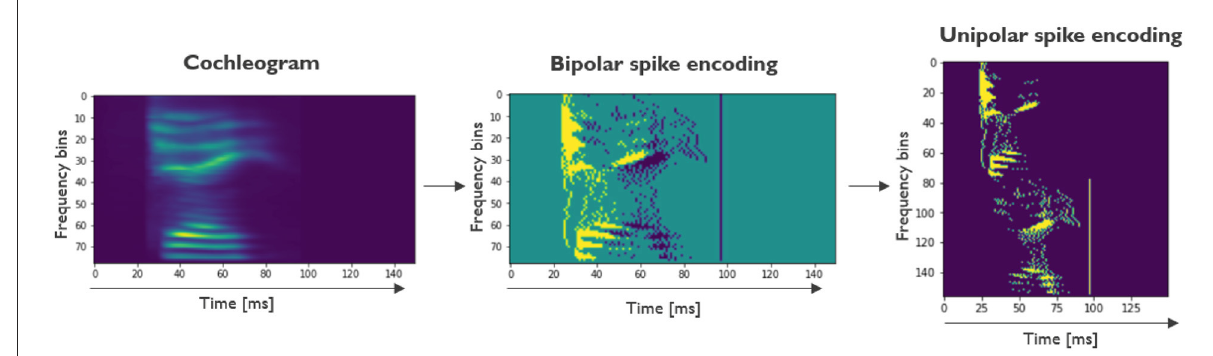
FIGURE2 Preprocessing pipeline shown on a training sample of the TI-Alpha data set. First, the sound files are transformed into a cocheogram, where the relative intensities are shown for various frequency bins. Next, the output of the step-forward encoding is shown, a bipolar spike encoding. The last step consists of a transformation to a unipolar encoding scheme, where the positive and negative spikes are split between different channels. The unipolar encoding can directly be used as input spike trains for the LSM.